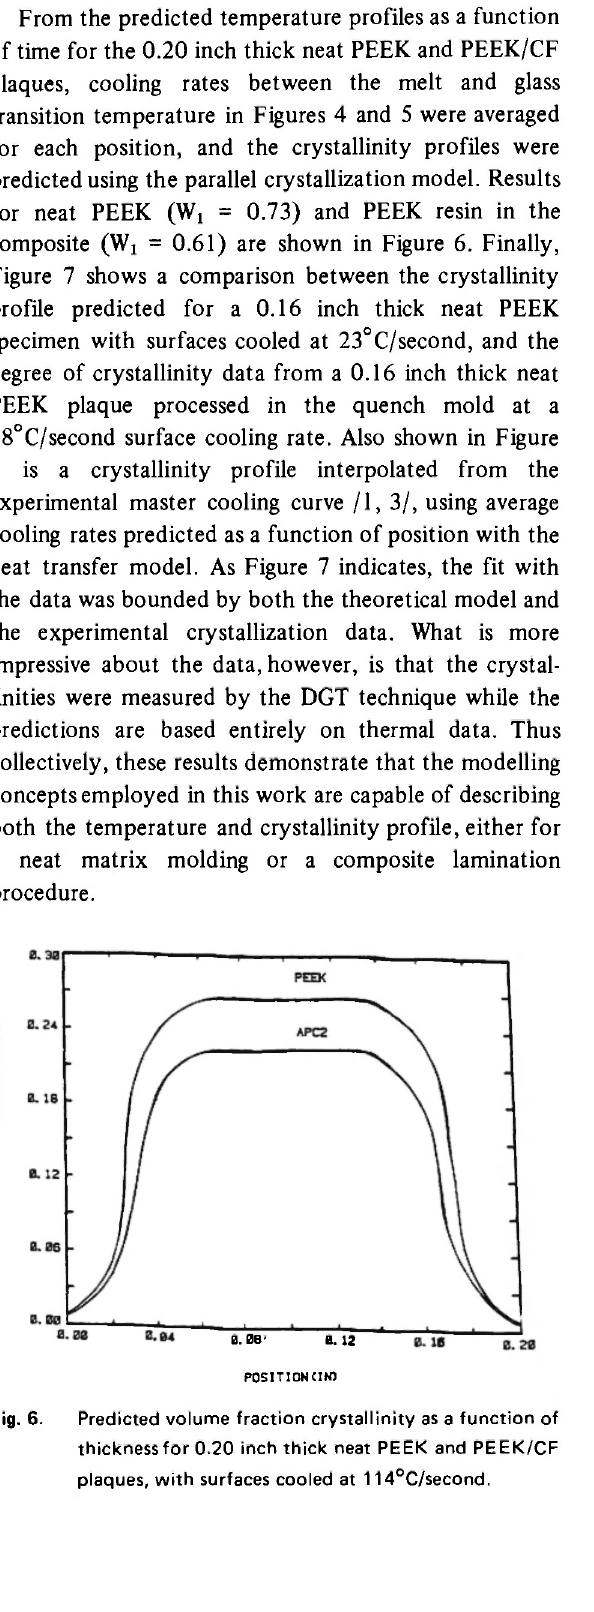
Predicted volume fraction crystallinity as a function of thicknessfor 0.20 inch thick neat PEEK and PEEK/CF plaques, with surfaces cooled at 114°C/second.